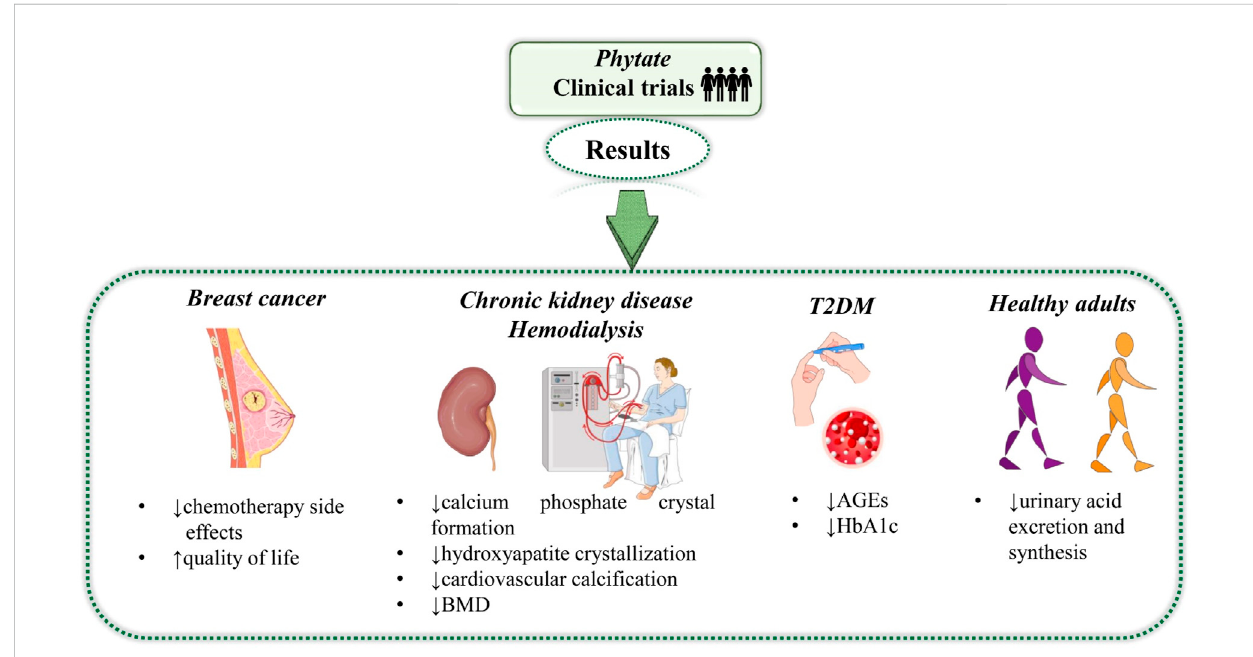
FIGURE 3 Summarizeddiagramwiththemostrelevantresultsofnaturalandarti fi cialformsofphytate.Abbreviationsandsymbols: ↓ decrease, ↑ increase,AGEs, glycation end-products and HbA1c, glycated